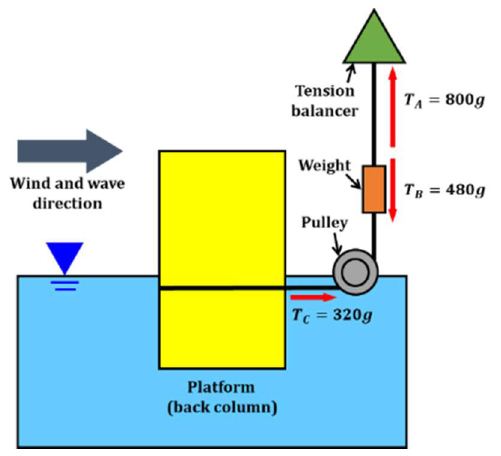
Figure 6. Current-imitating device.